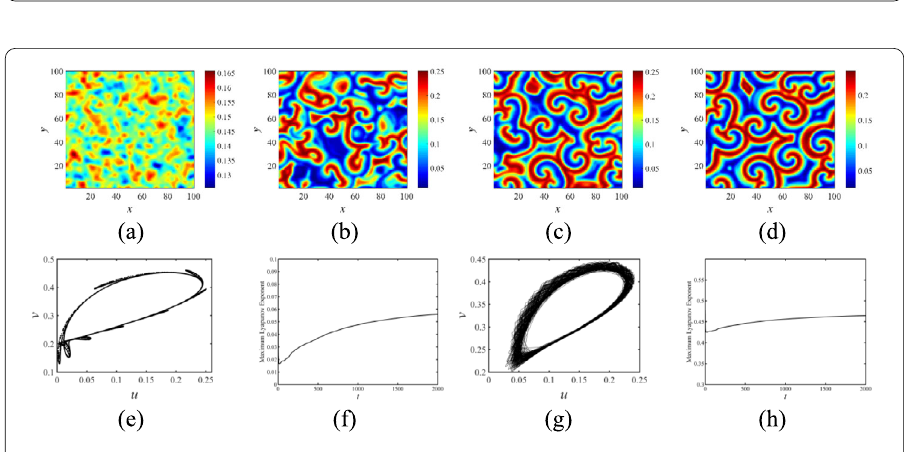
Figure 8 Self-organziation and nonlinear properties of a spiral pattern. ( a )–( d ) Evolution of the prey pattern at transient times t = 10, t = 100, t = 200, and t = 500, respectively; ( e )–( h ) phase portraits and maximum Lyapunov exponent diagrams in the cases of uncoupling and coupling the population diffusion. The parameter values are given as a = 1.1, e 1 = 0.3, e 2 = 0.2, b = 0.3739, τ = 3.59, δ = 1, h = 8, n = 100